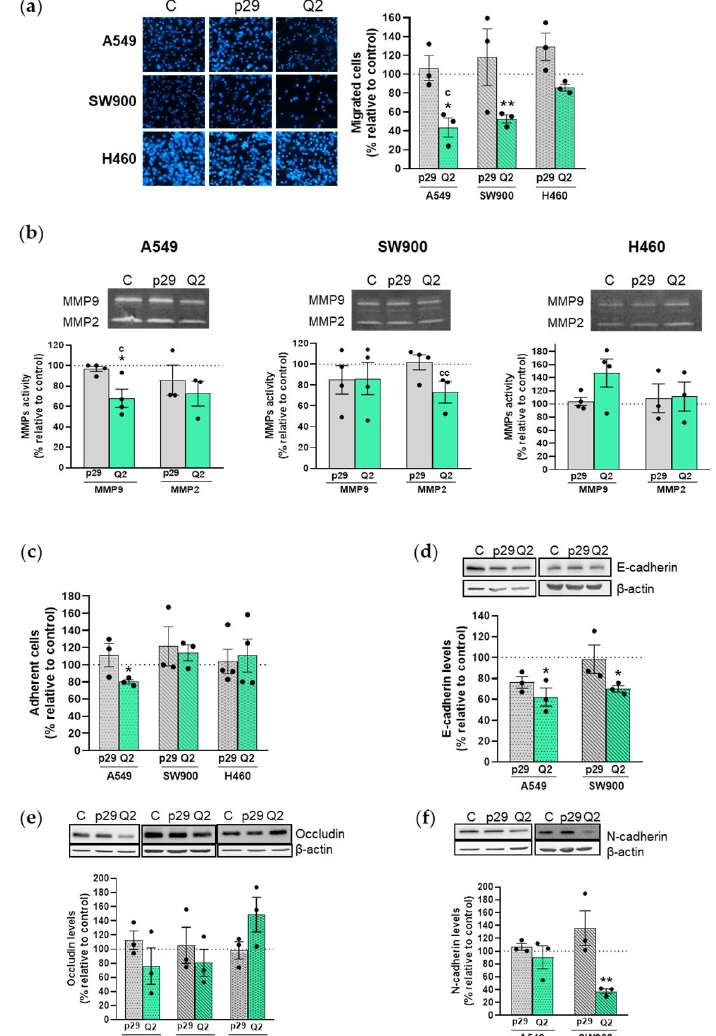
Figure 4. ApMNKQ2-mediated effects on migration, invasion, and EMT in NSCLC cells. ( a ) Cells were transfected with aptamers at IC50, maintained in serum-deprived medium for 16 h, and collected and reseeded at 4 × 10 4 cells/well in the upper chamber of a transwell. Representative images are shown in the left panel. The graphs represent the mean percentage of migrated cells ± SEM relative to the value of control (C) cells from 3 independent experiments. ( b ) Zymography was performed as described in Materials and Methods. The graphs represent the mean percentage of MMP activity ± SEM relative to the value of control (C) cells from 3–4 independent experiments. ( c ) Cells were transfected with aptamers at IC50 and reseeded in plates previously coated with type I collagen. After binding, cells were quantified by MTT assay. The graphs represent the mean percentage of adherent cells ± SEM relative to the value of control cells from 3 independent experiments. ( d – f ) Western blot and corresponding densitometry analyses of lysates (20 µ g) that were subjected to SDS-PAGE (10%). Specific antibodies are shown in Supplementary Table S1. Actin detection was used as a loading control. A representative blot is shown at the top of each graph. Densitometric quantification of E-cadherin, occludin, and N-cadherin was normalized to respective β -actin bands, and levels are expressed as a percentage relative to control cells. The graphs represent mean percentage levels ± SEM of 3 independent experiments. * p < 0.05 and ** p < 0.01 relative to control cells; c p < 0.05 and cc p < 0.01 relative to p29 control. Control is shown as C, p29 is the unspecific aptamer used as a negative control, and apMNKQ2 is shown as Q2. Each solid black circle represents one individual